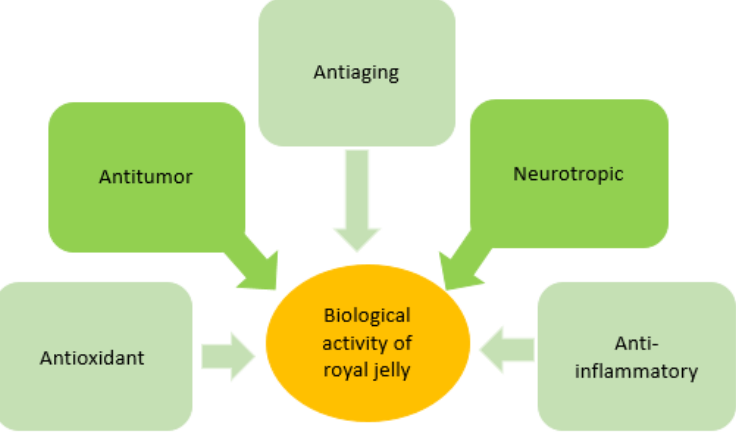
Figure 7. Biological properties of royal jelly (adapted from [69]).